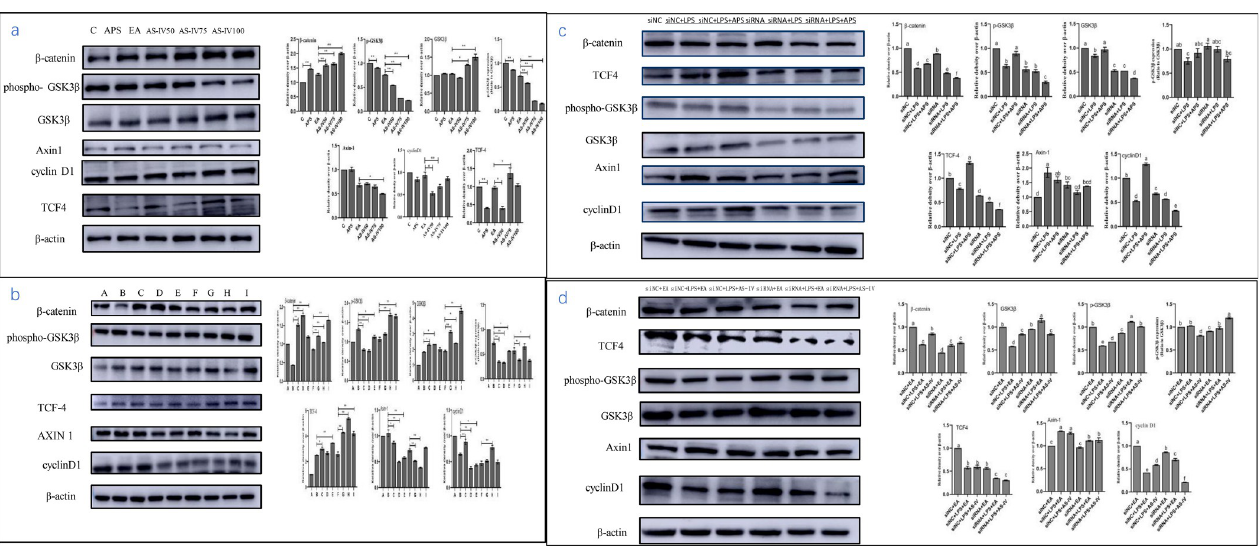
Fig 4. APS and AS-IV regulation of the Wnt/ β -catenin signaling pathway in BMECs. (a) APS and AS-IV activate the Wnt/ β -catenin signaling in BMECs. C = Control cells without any processing; APS = cells treated with 1 mg/mL APS; EA = negative control for AS-IV (ethanol concentration was the same as that in AS-IV 100 μ g/mL, ethanol concentration 1%); AS-IV50 = cells treated with 50 μ g/mL AS-IV; AS-IV75 = cells treated with 75 μ g/mL AS-IV; AS-IV100 = cells treated with 100 μ g/mL AS-IV. (b) APS and AS-IV activate Wnt/ β -catenin signaling in inflammatory state BMECs. A = Control cells without any processing; B = cells treated with LPS (0.5 μ g/mL); C = LPS (0.5 μ g/mL) + APS (1 mg/mL); D = LPS (0.5 μ g/mL) + lincomycin (50 μ g /mL); E = LPS (0.5 μ g/mL) + penicillin (86U/mL � 50 μ g/mL); F = LPS (0.5 μ g/mL) + ethanol concentration 1% (vol/vol); G = LPS (0.5 μ g/mL) + AS-IV(50 μ g/mL); H = LPS (0.5 μ g/mL) + AS-IV(75 μ g/mL); I = LPS (0.5 μ g/mL) + AS-IV(100 μ g/mL). (c, d) Silencing of β -catenin abolishes the ability of APS and AS-IV to regulate the Wnt/ β - catenin signaling pathway. siNC = cells treated with NC-siRNA alone; siNC + LPS = NC-siRNA+ LPS (0.5 μ g/mL); siNC + LPS + APS = NC-siRNA + LPS (0.5 μ g/mL) + APS (1 mg/mL); siRNA = cells treated with 1225-siRNA alone; siRNA + LPS = 1225-siRNA + LPS (0.5 μ g/mL); siRNA + LPS + APS = 1225-siRNA+LPS (0.5 μ g/mL) + APS (1 mg/mL). siNC + EA = NC-siRNA+ ethyl alcohol (1% vol/vol); siNC + LPS + EA = NC-siRNA + LPS (0.5 μ g/ mL) + ethyl alcohol (1% vol/vol); siNC + LPS + AS-IV = NC-siRNA+LPS (0.5 μ g/mL) +100 μ g/mL AS-IV (100 μ g/mL); siRNA + EA = 1225-siRNA+ ethyl alcohol (1% vol/vol); siRNA + LPS + EA = 1225-siRNA+LPS (0.5 μ g/mL) + ethyl alcohol (1% vol/vol); siRNA + LPS + AS-IV = 1225-siRNA + LPS (0.5 μ g/mL) +100 μ g/mL AS-IV (100 μ g/mL). Protein blots were used to determine relative protein expression levels. β -actin was used as a control. Data are expressed as mean ± SD of 3 independent experiments. � represents 0.01 < P < 0.05, �� represents P < 0.01 and letter differences in the graph indicate significant differences between groups, P <